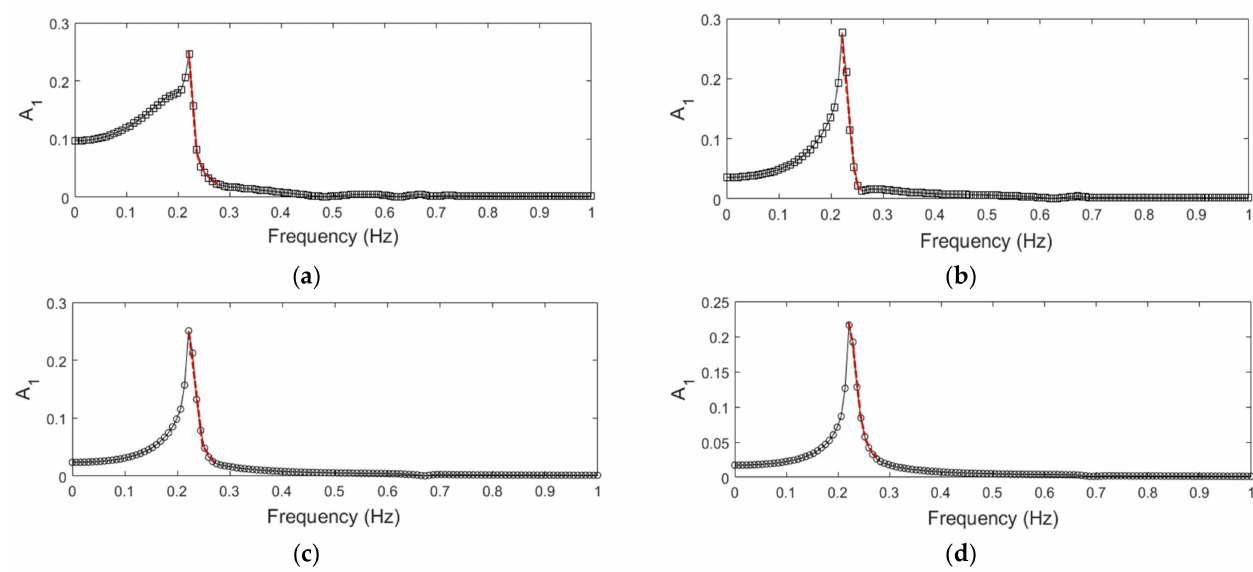
Figure 10. Frequency response curves under different excitation amplitudes ( µ = 0.4, λ = 0.2, ζ = 0.05, ε = 2): ( a ) u 0 Ω 2 = 880; ( b ) u 0 Ω 2 = 870; ( c ) u 0 Ω 2 = 860; ( d ) u 0 Ω 2 =